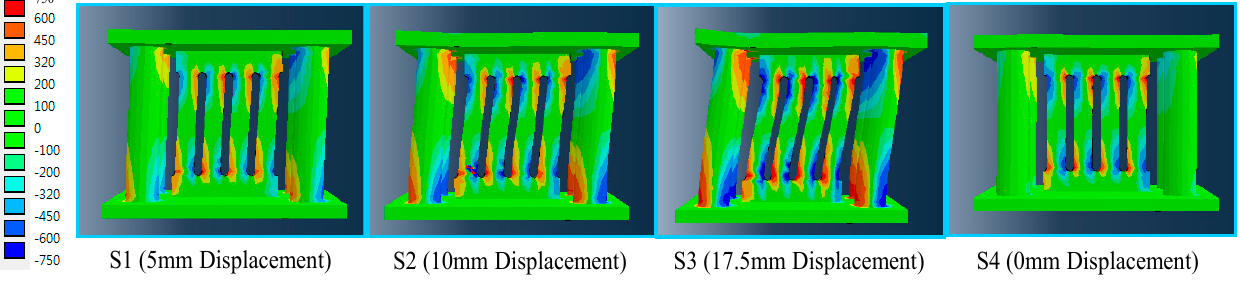
Figure 14. Axial stress components (S11) distributed over the slip plate damper (SL4-SMA model) according to individual loading steps (Unit: